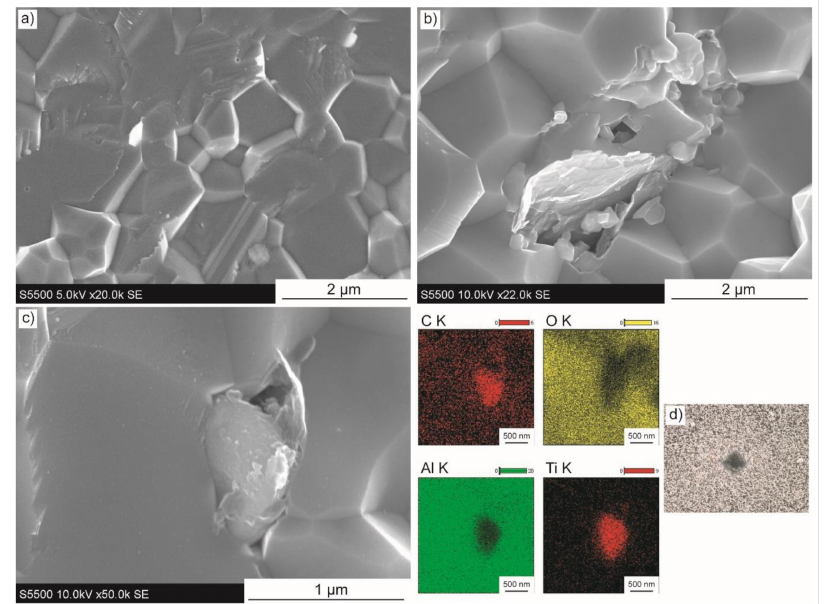
Figure 7. Microstructure images of composites with Ti 3 C 2 -Ti addition of ( a , b ) 2 wt.%, ( c ) 2 wt.% with EDS map of elements, ( d ) 0.5 wt.% with Vickers indenter